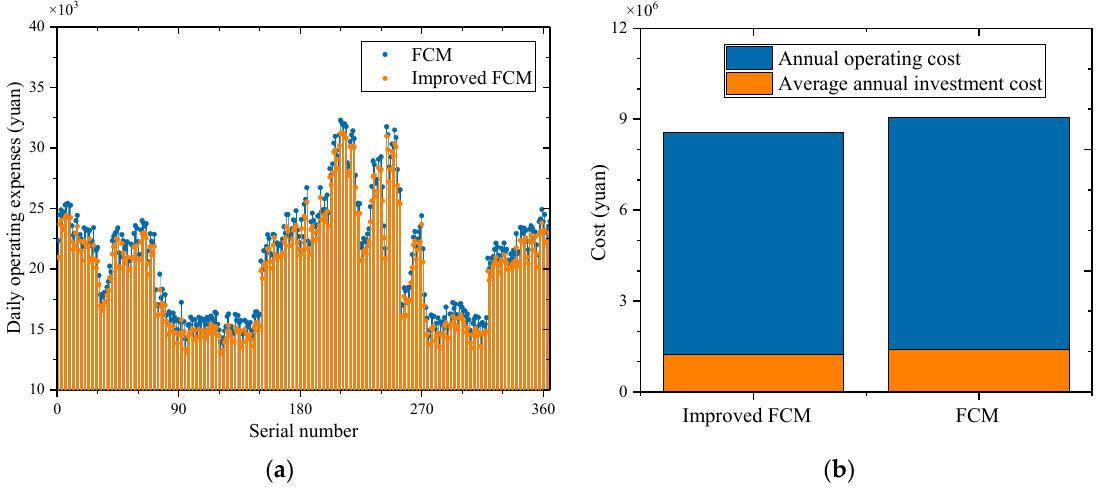
Figure 16. ( a ) Daily operating cost and the total annual cost; ( b ) annual operating cost and the total annual cost.